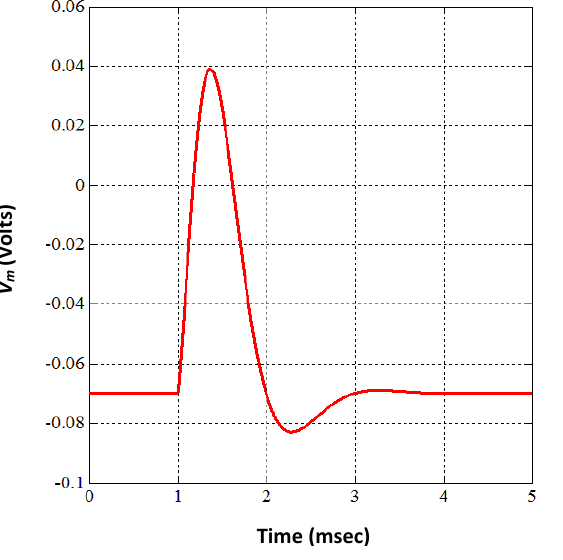
Fig.1: The completely depolarized membrane potential (4b) exhibits stable equilibrium for ξ = 0.5 e . † This plot was time-shifted to the right by 1 ms (intentioanlly) to visually enhance the action potential